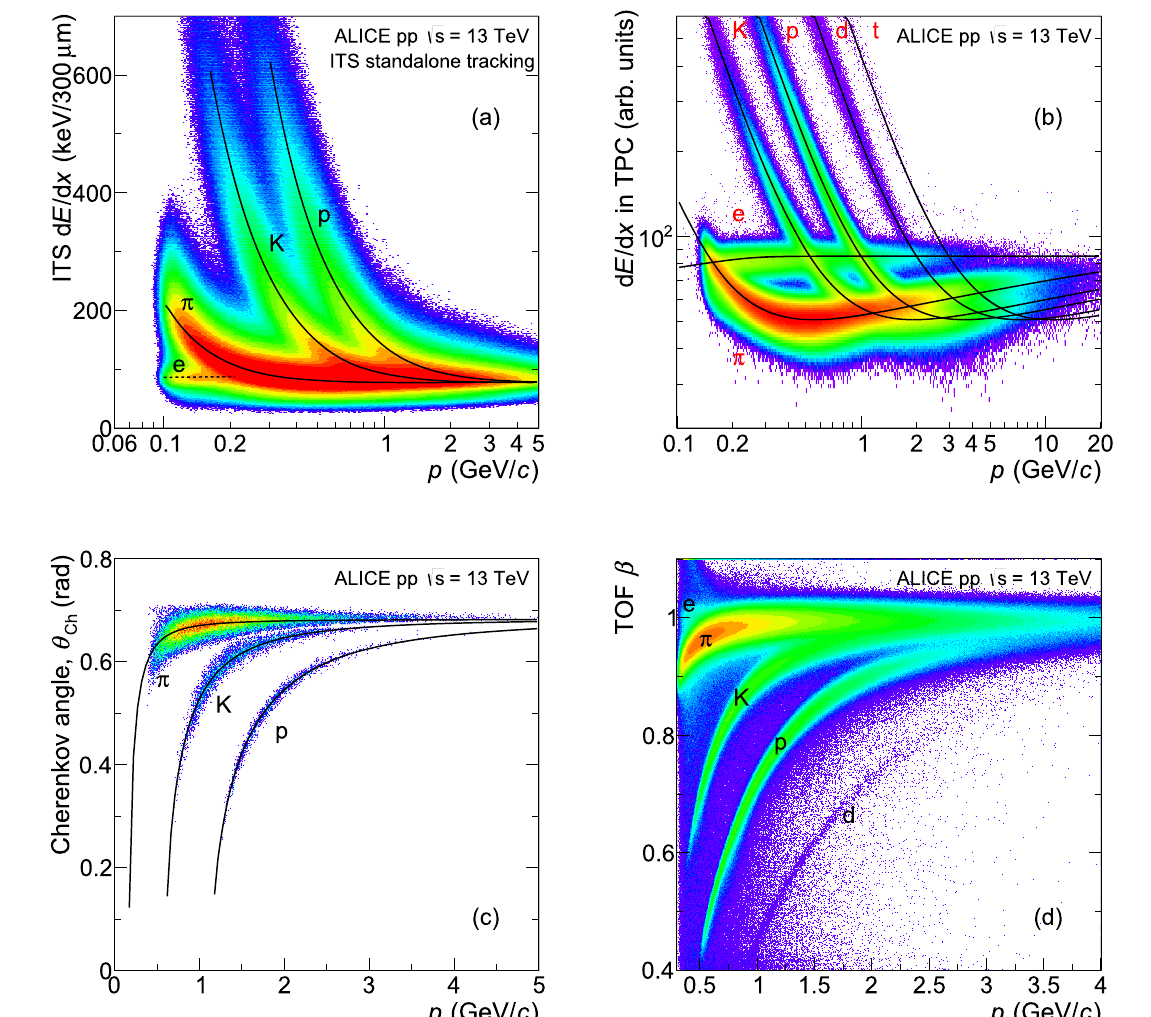
Fig. 1 The performance during the LHC Run 2 period of the ALICE central barrel detectors used for the measurements described in this paper. Panels a – d indicate the characteristic signal distributions of identified charged particles measured by the ITS, TPC, TOF, and HMPID detector, respectively